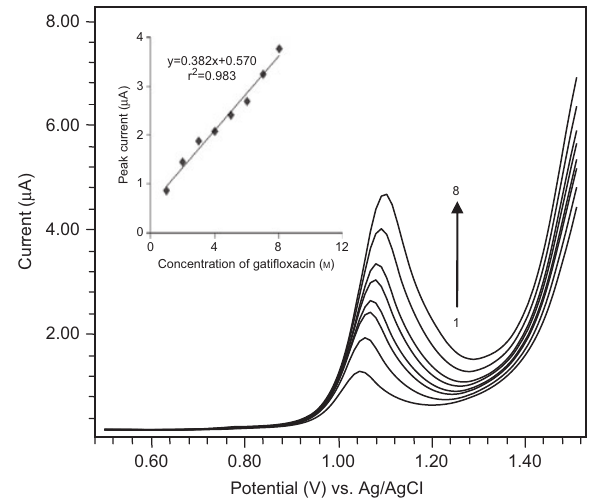
Figure 3 The dependence of the DPV peak current of gatifl oxacin in acetate buffer at pH 5.0 at different concentrations (1) 2.13 × 10 -5 m , (2) 2.66 × 10 -5 m , (3) 6.39 × 10 -5 m , (4) 8.52 × 10 -5 m , (5) 1.0 × 10 -4 m , (6) 1.3 × 10 -4 m , (7) 1.5 × 10 -4 m , (8) 1.7 × 10 -4 m , pulse amplitude 50 mV, scan rate 50 mVs -1 , deposition time 60 s.